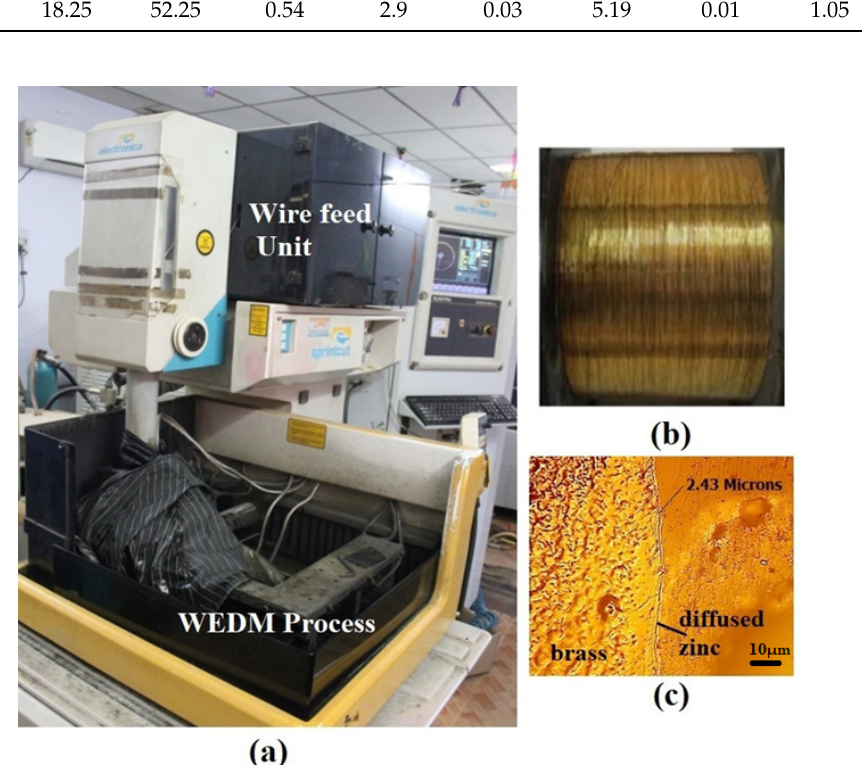
Figure 1. WEDM process arrangement: ( a ) Experimental setup; ( b ) Zinc-diffused brass wire electrode, and ( c ) Micro structure of wire electrode.